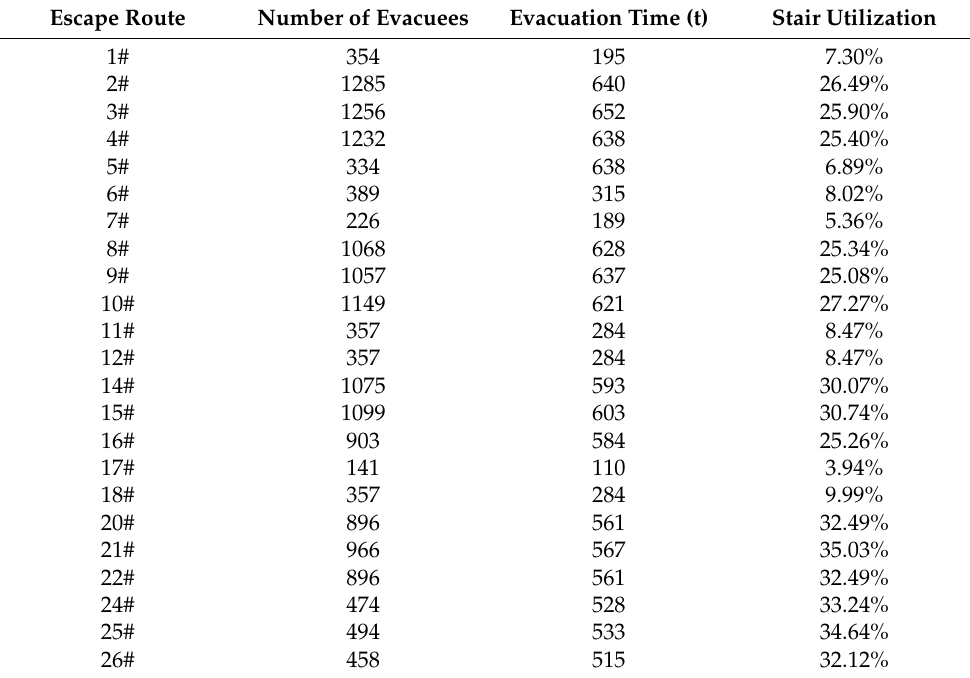
Table 4. Evacuation time and number of evacuees in case of